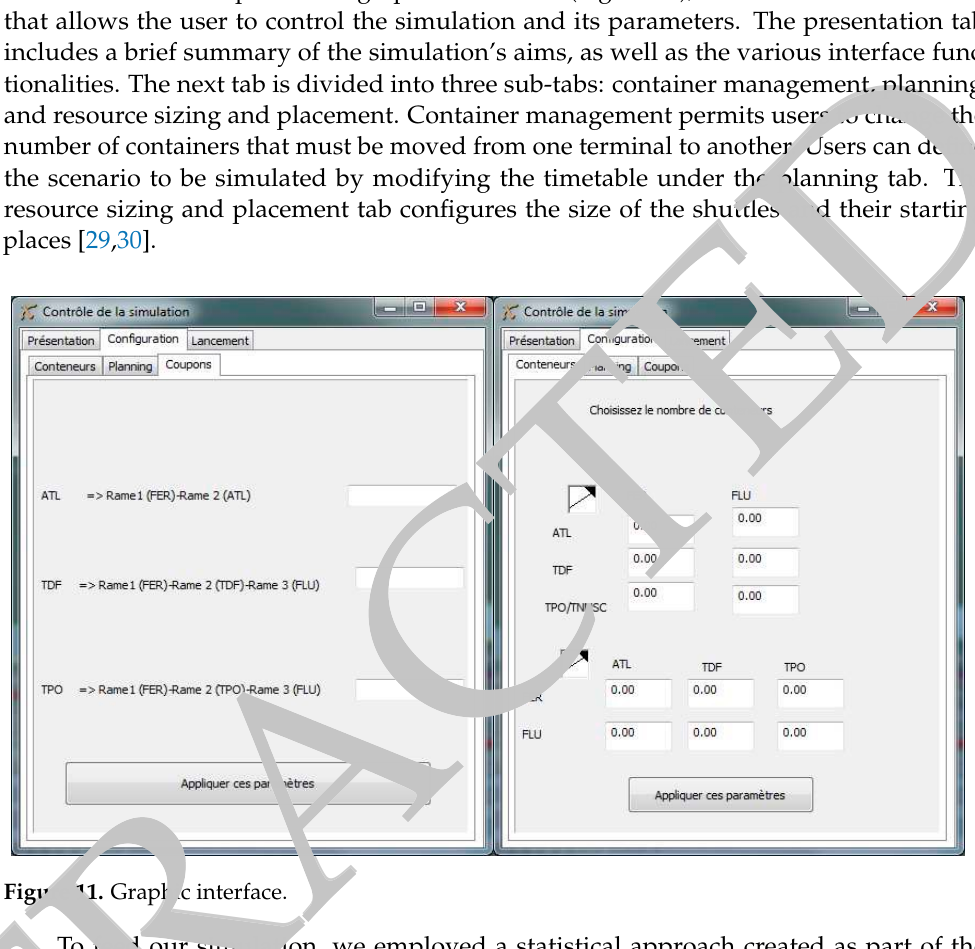
Figure 11. Graphic interface.